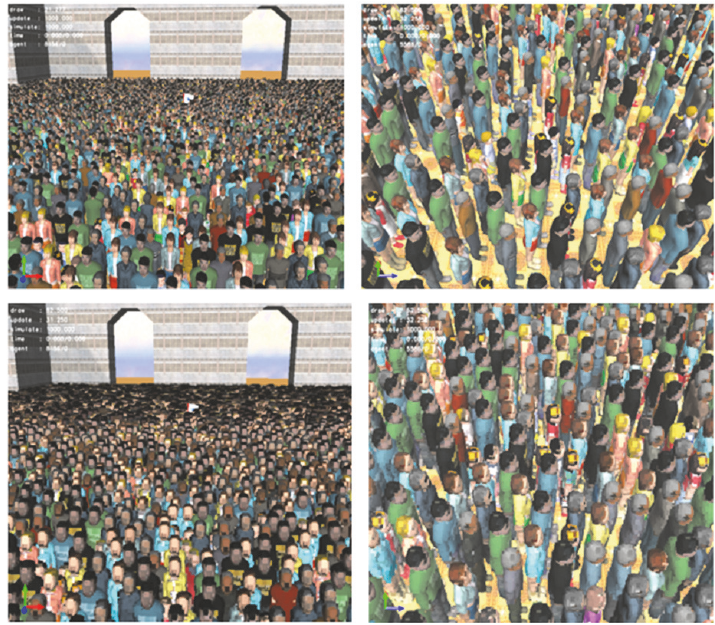
Figure 4: Rendering effect of different sampling